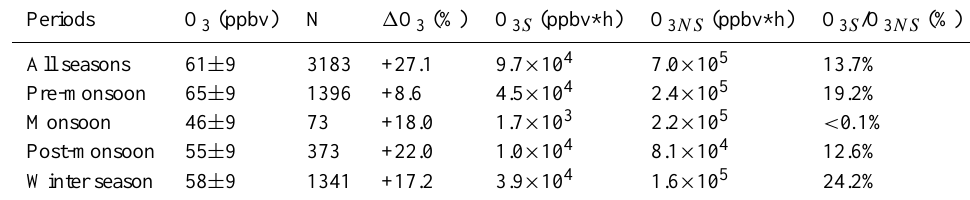
Table 2. For periods affected by SI at the NCO-P: seasonal averaged O 3 concentration (O 3 ), number of 30-min observations (N), O 3 excess ( 1 O 3 ) and maximum O 3 integral (O 3 S , see Sect. 5 for definition). Seasonal averaged integral O 3 outside SI (O 3 NS ) and seasonal maximum O 3 enhancement ratios (O 3 S /O 3 NS ) at NCO-P are also reported. Periods O 3 (ppbv) N 1 O 3 (%) O 3 S (ppbv*h) O 3 NS (ppbv*h) O 3 S /O 3 NS (%) All seasons 61 ± 9 3183 +27.1 9.7 × 10 4 7.0 × 10 5 13.7% Pre-monsoon 65 ± 9 1396 +8.6 Monsoon 46 ± 9 73 +18.0